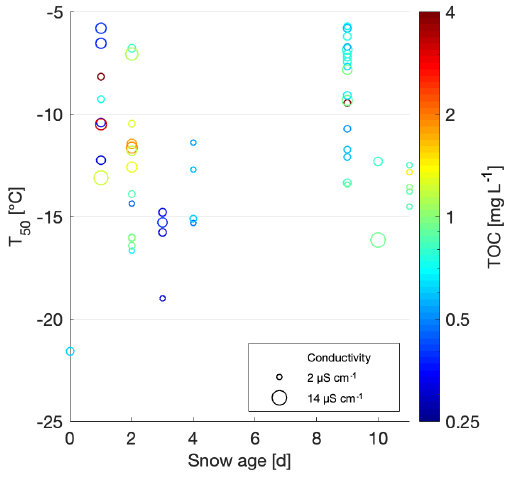
Figure 9. Scatterplot of T 50 versus minimum snow age. TOC values of the samples are shown on a color scale, and the marker surface area represents the